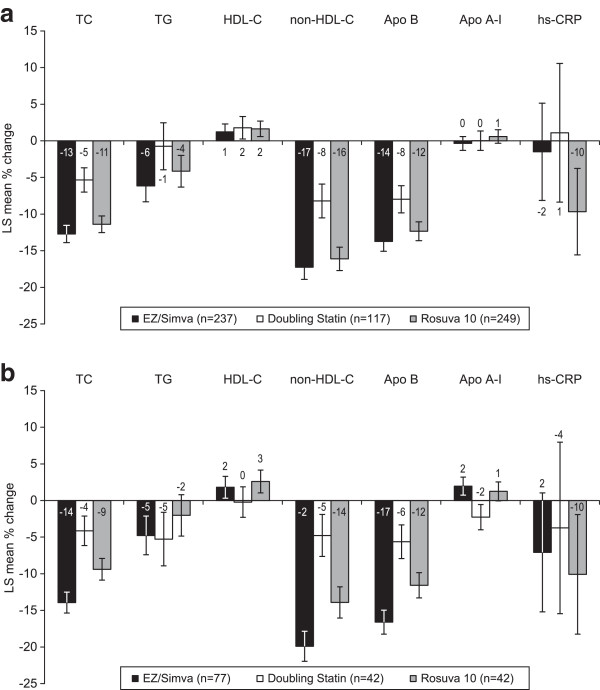
Least squares mean percent change from baseline in lipids, lipoproteins and hs-CRP after 6 weeks of treatment. Bars represent standard error. (FAS population). a. Obese subjects. b. non-obese subjects.